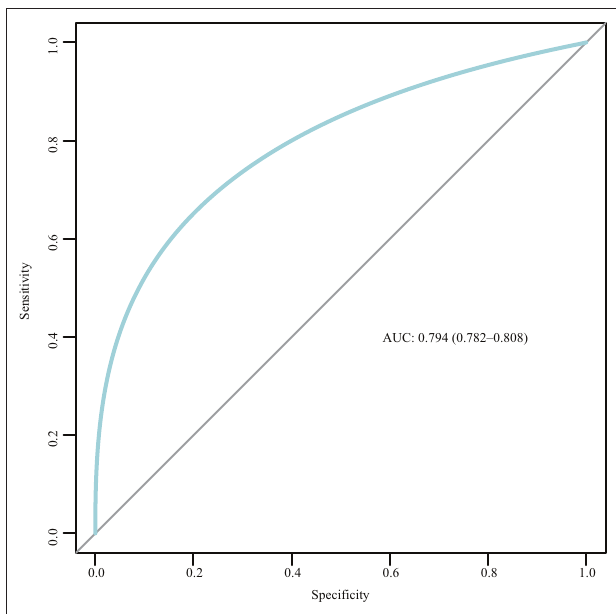
FIGURE 2 | Receiver operating characteristic (ROC) curve for the nomogram. AUC, area under the curve; ROC, receiver operating characteristic.